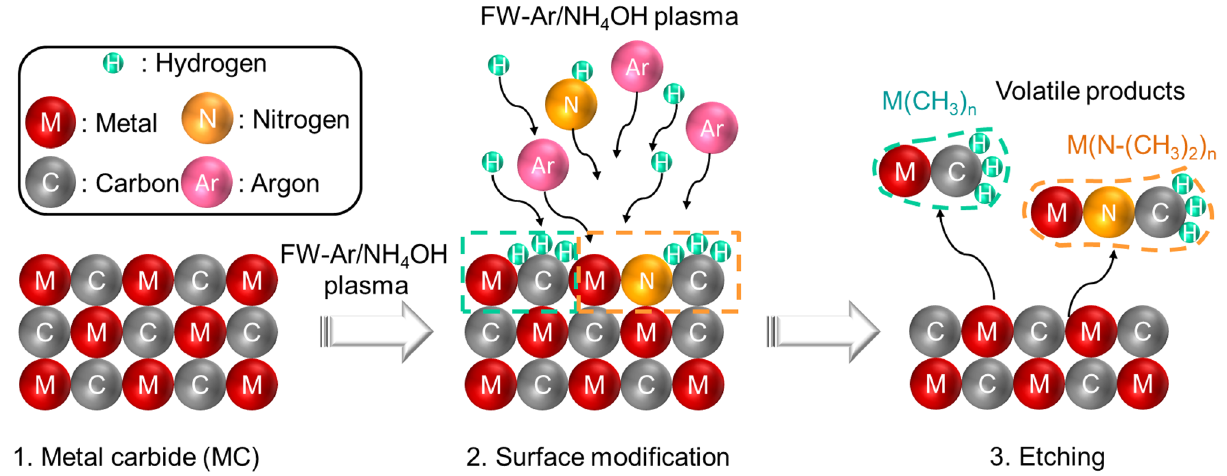
Figure 8. Proposed mechanism for plasma etching of metal carbide (MC) using FW-Ar/NH 4 OH